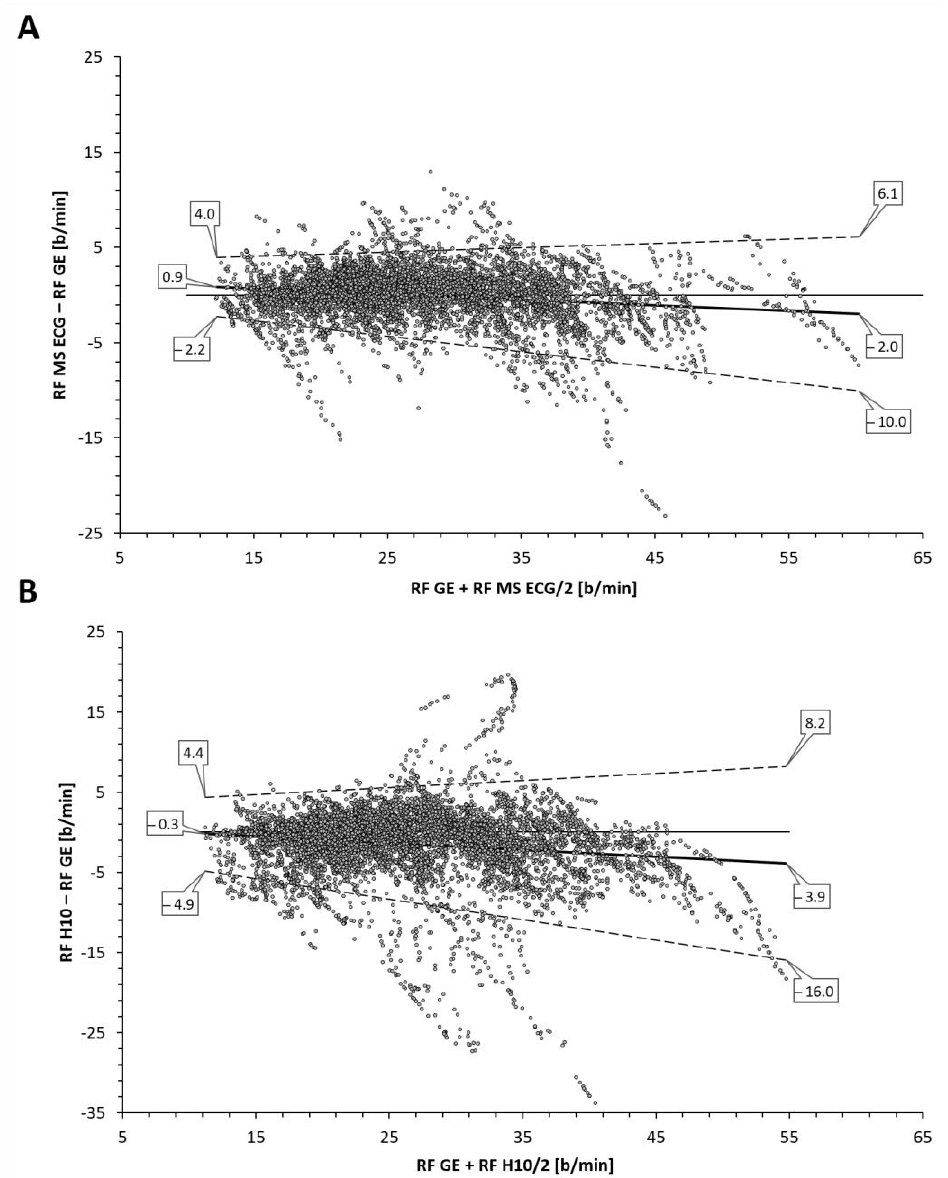
Figure 2. Bland–Altman analysis of respiratory frequency (RF) as breaths/min (b/min) for the ( A ) Movesense Medical sensor ECG (MS ECG) and the ( B ) Polar H10 sensor chest belt device (H10) vs the gas exchange data (GE) during the incremental exercise test until voluntary exhaustion. Center solid line in each plot represents the mean bias (difference) between each paired value as absolute values. The top and bottom dashed lines are LoA (1.96 standard deviations from the mean difference).